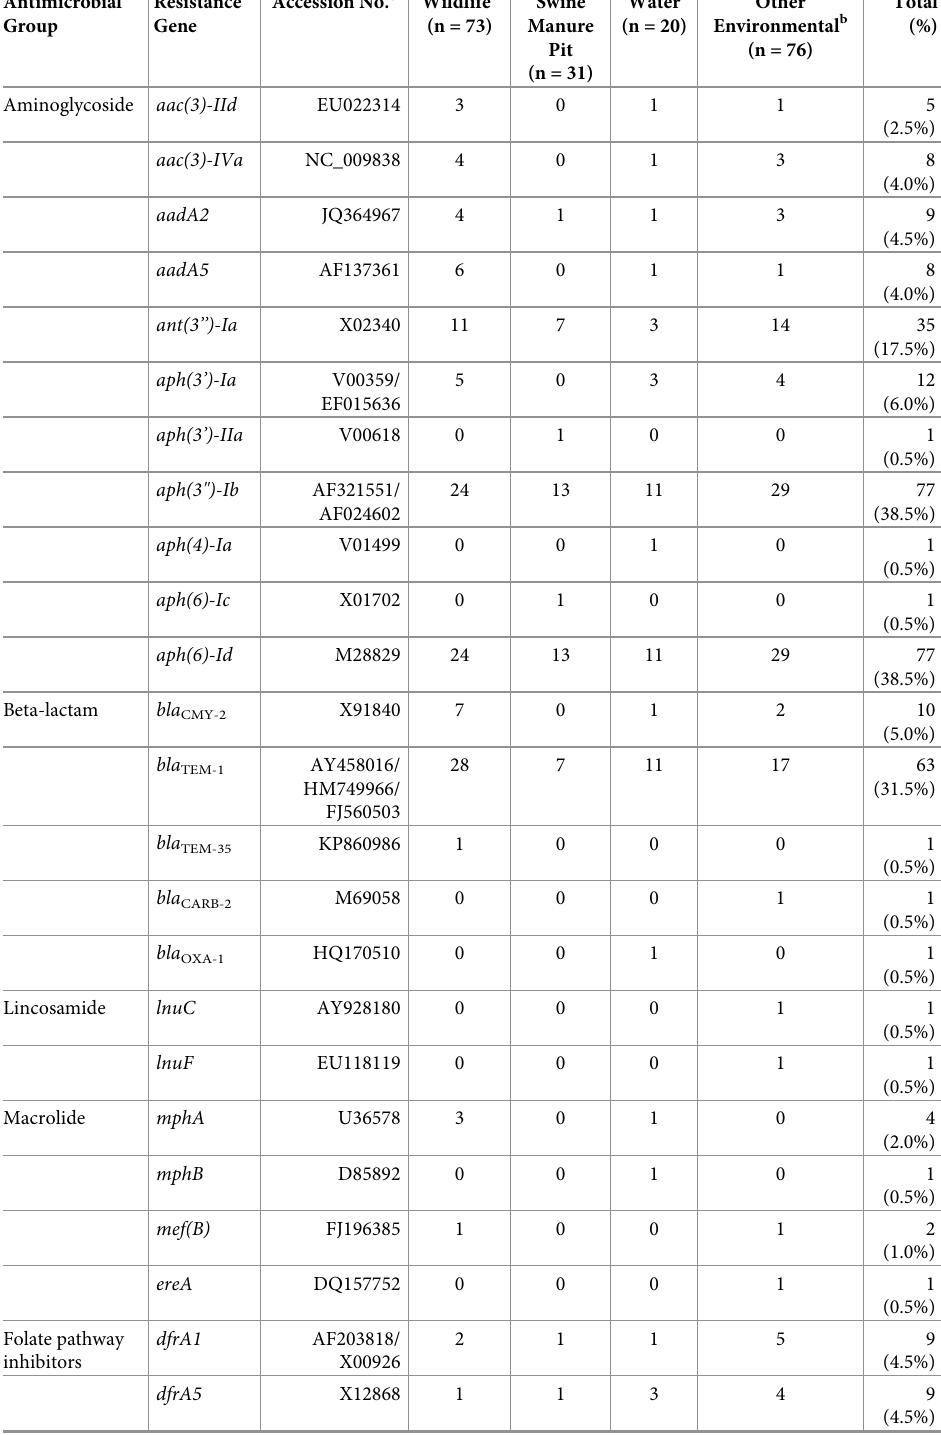
Table 2. Frequencies of acquired antimicrobial resistance genes identified using whole-genome sequence data from phenotypically resistant Escherichia coli isolates from wildlife, swine manure pits, and environmental sources in southern Ontario, Canada 2011 − 2013(n =